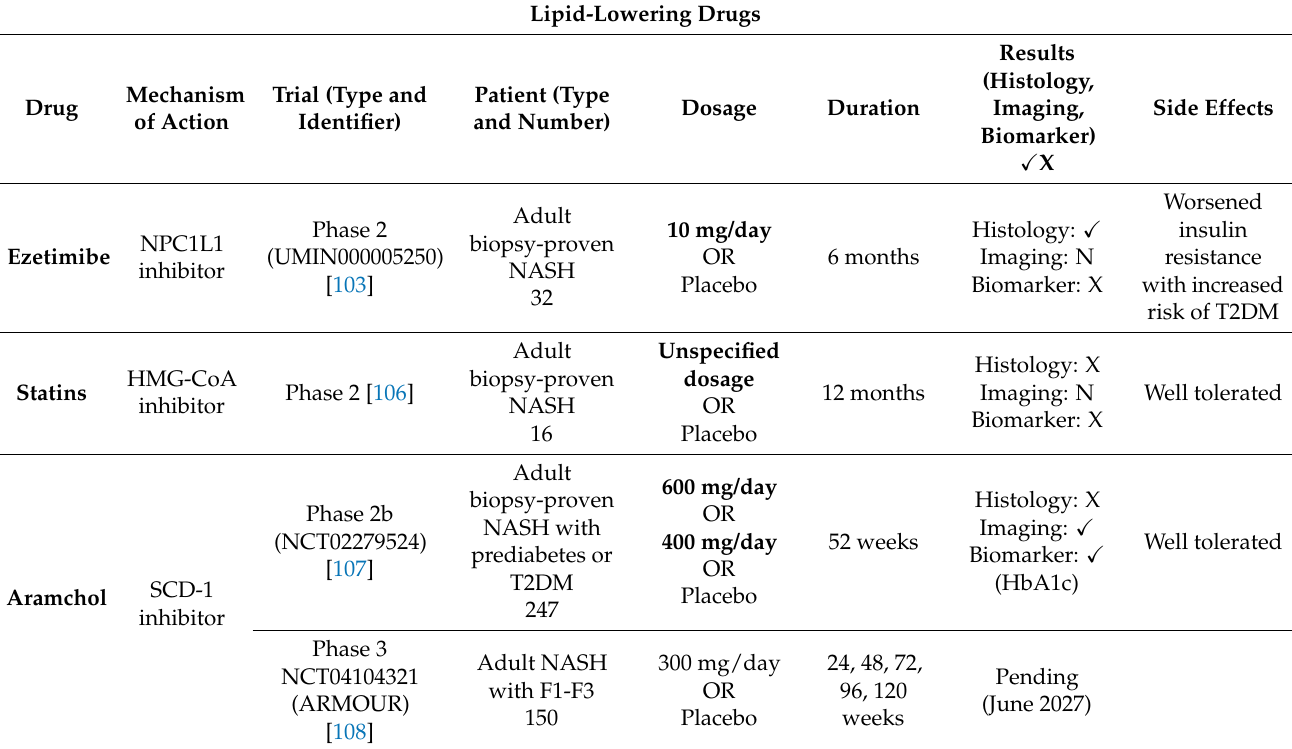
Table 6. Clinical trials on lipid-lowering drugs evaluated. Lipid-Lowering